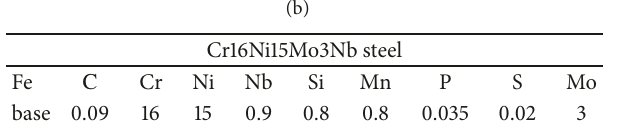
Figure 1: VCG-135 test bench.